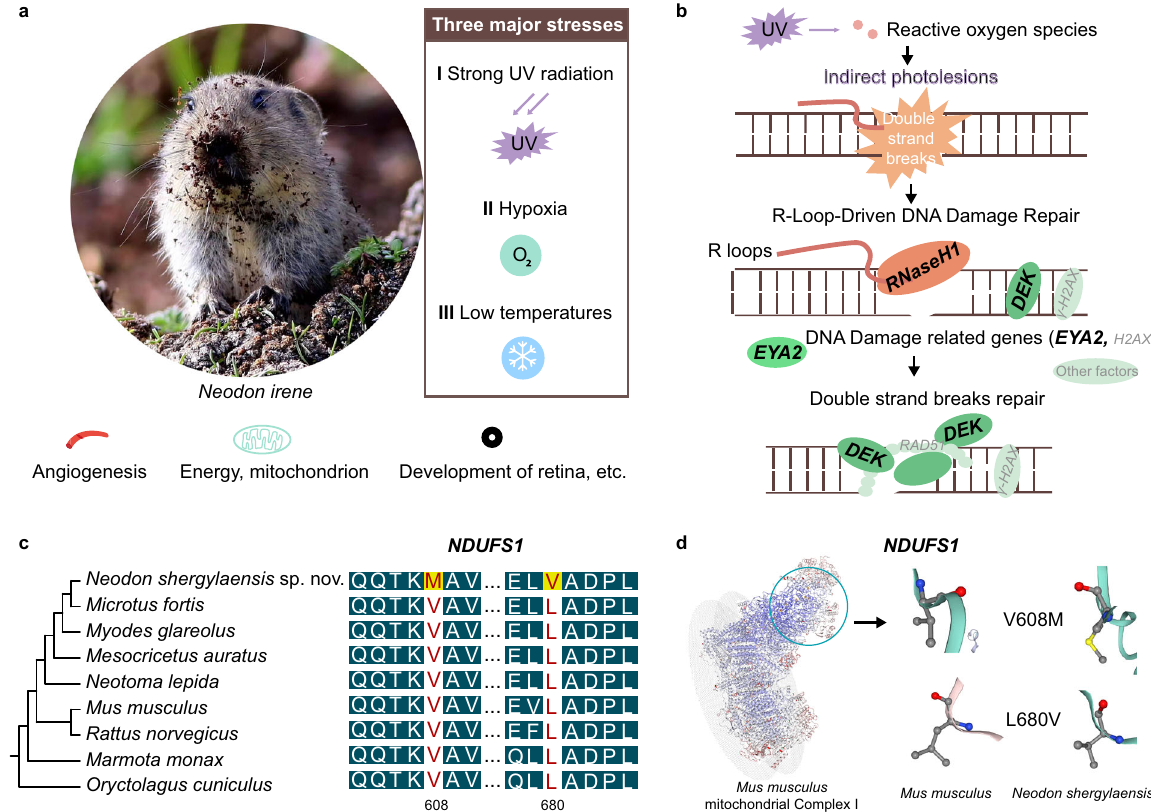
Fig. 5 Gene functional adaptations in Neodon species. a The three major environmental stresses of high-elevation areas and the adaptive traits that the voles may have developed (Photograph by Shaoying Liu). b The repair of DNA double-strand breaks damage, involving the three PSGs of RNaseH1, EYA2 and DEK , is a classic DNA repair pathway for UV-induced DNA damage. c Visualisation of two positively selected gene sites in the NDUFS1 gene, which represents one of the PSGs related to mitochondrial function. d Mitochondrial complex I and positive selection sites affect the protein structure of NDUFS1